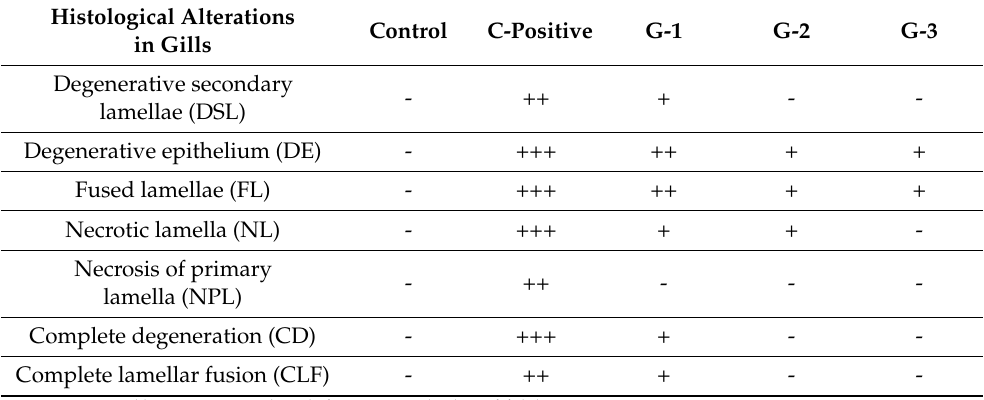
No symptoms (-); very severe (+++); less severe (++); mild